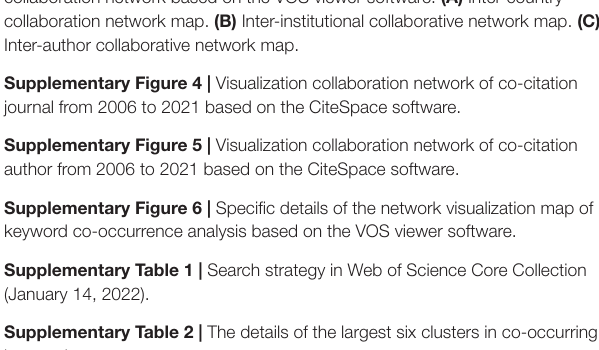
Supplementary Figure 1 | Conceptual design of the study. Supplementary Figure 2 | The cross-country collaborations visualization map was generated by the online bibliometric analysis. Supplementary Figure 3 | Visualization knowledge maps of the scientific collaboration network based on the VOS viewer software. (A) Inter-country